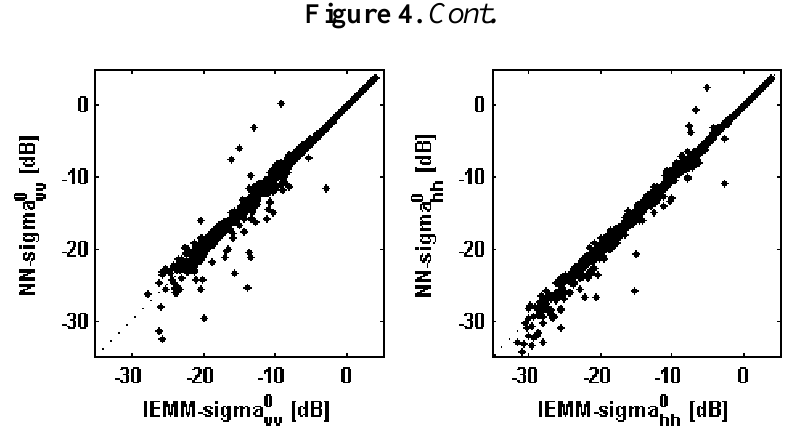
assumed as an additional input parameter. i